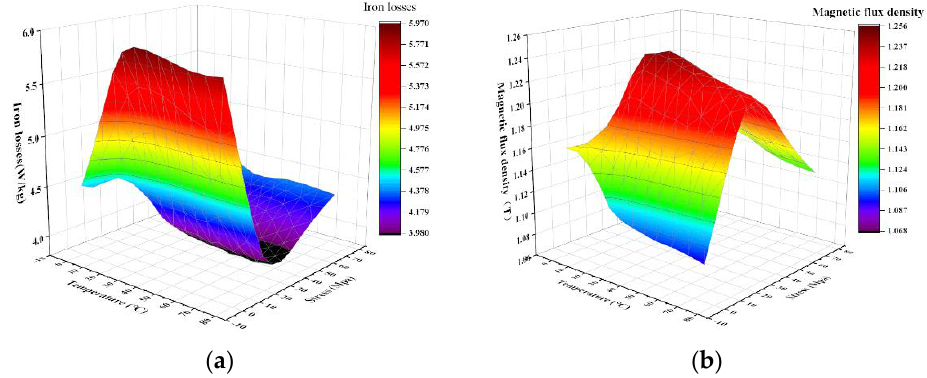
Figure 8. Magnetic properties of grain-oriented silicon steel under multi-physical field coupling ( a ) loss variation in H-80 under tensile stress @1 T and 400 Hz; ( b ) magnetic density variation in H-80 under tensile stress@1000 A/m and 50 Hz.